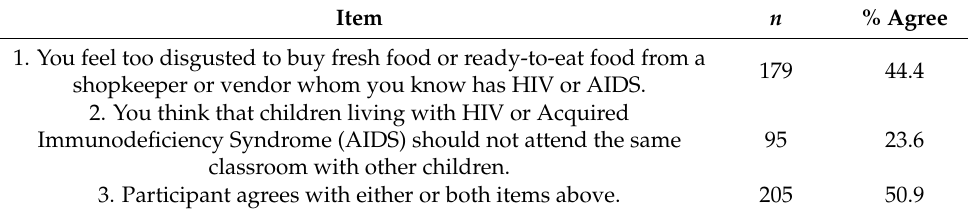
Table 2. HIV stigmatizing attitude ( n = 403) a